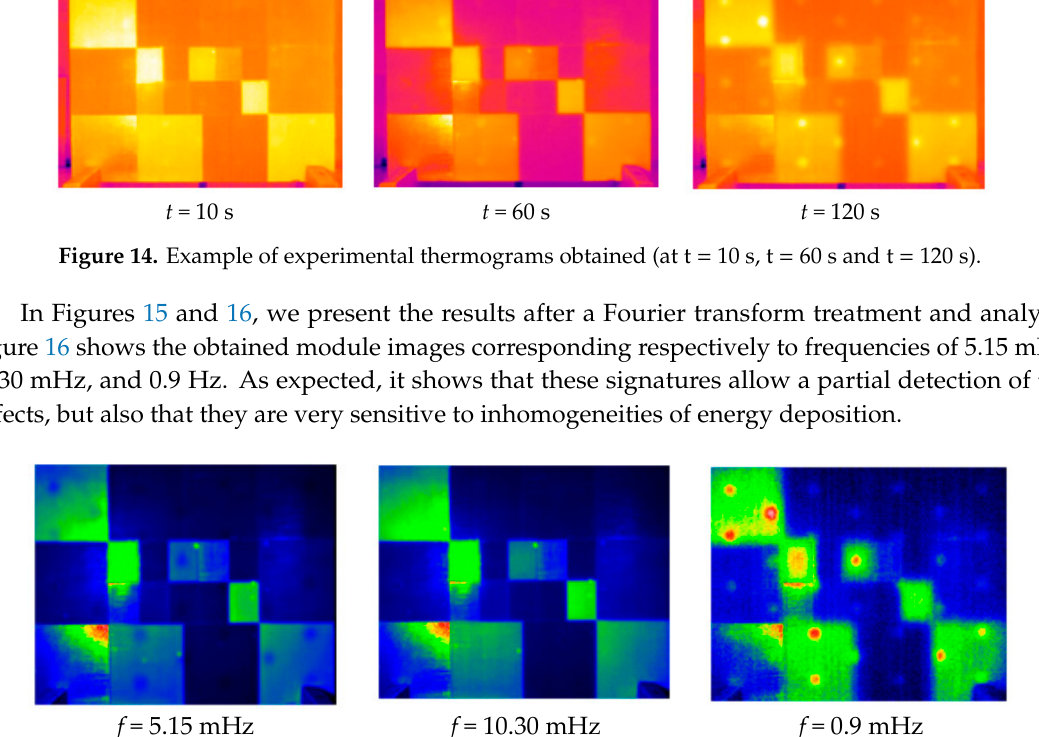
Figure 4. Example of theoretical thermograms obtained (t = 28 s, t = 91 s, t = 177 s and t = 200 s).